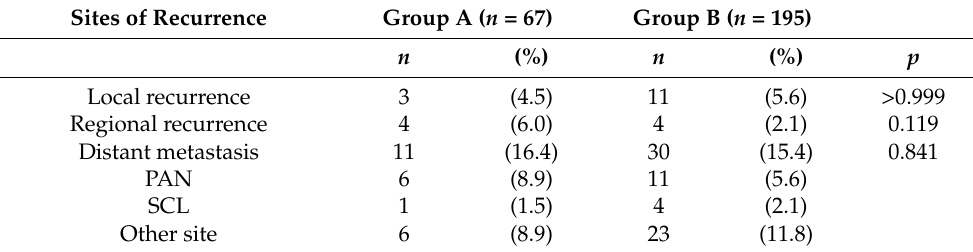
Table 3. Patterns of